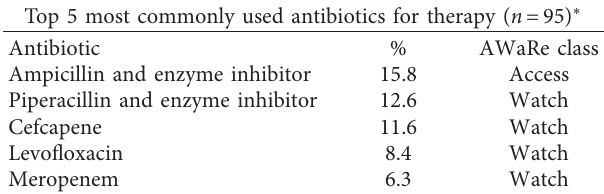
Table 2: Top five most commonly used antibiotics for treating inpatients at the Maruki Memorial Welfare and Medical Center, Japan, in November 2018, January 2019, and May